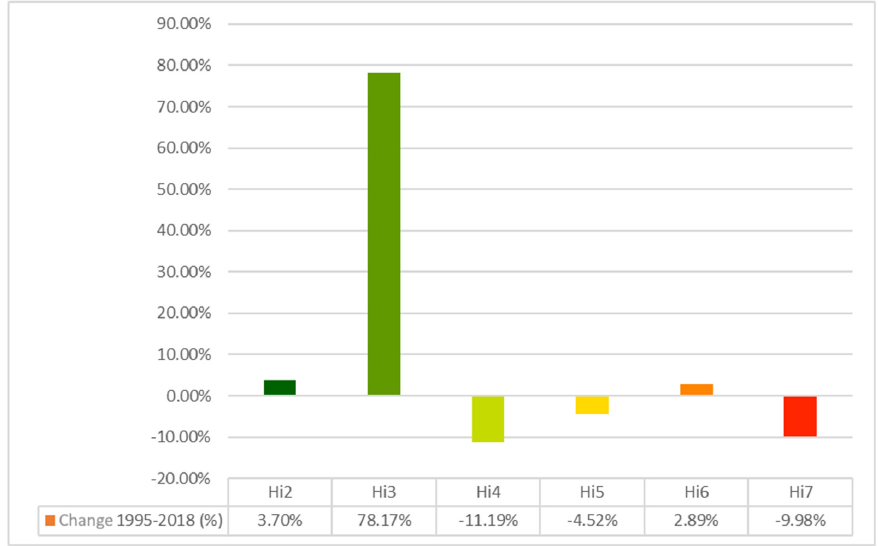
Figure 3. Overall land cover naturalness change in Lithuania, 1995–2018 (differentiated by percent- age change). Figure 4. Land-cover change trends (tendencies) 1995–2018.